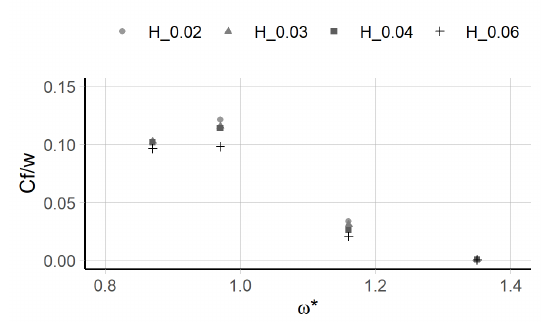
Figure 10. Capture factor against the non-dimensional wave frequency for different wave heights for a 1:40 scale OWSC model.